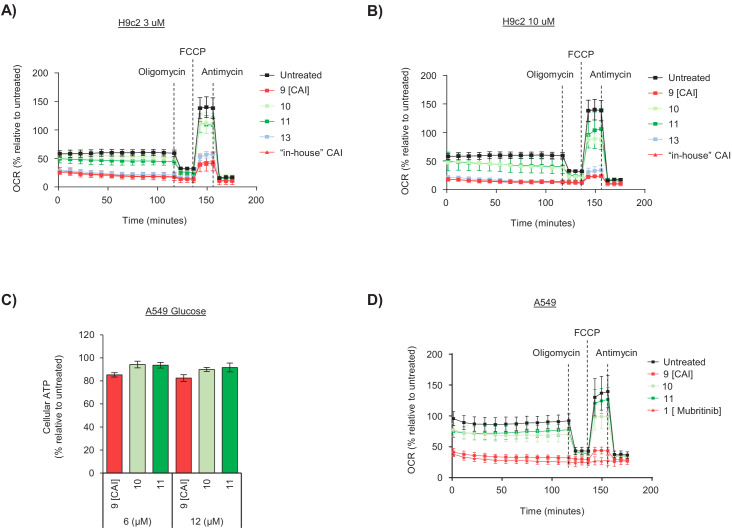
The toxicophore in CAI inhibits mitochondrial complex I.(A and B) Representative seahorse trace (for Figure 3C) of H9c2 cells grown in glucose containing media and treated with either (A) 3 μM or (B) 10 μM of the indicated compounds. (C) A549 cells were treated with 6 or 12 μM of CAI (9) or compound 10 and compound 11 in glucose containing media and after 24 hr ATP levels were measured and normalised to the untreated control. Error bars represent standard deviation (n = 3). (D) Representative seahorse trace (for Figure 3E) of A549 cells grown in glucose containing media and treated with 5 μM of either CAI (9), 10, 11; or 5 μM mubritinib.